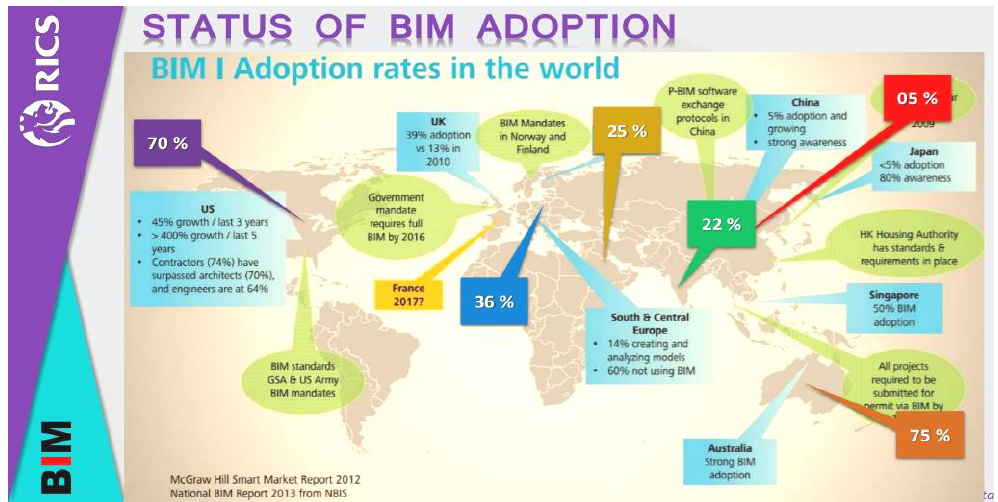
Fig. 4. Status of BIM-1 Study on BIM adoption rate in the world (Royal Institute of Chartered Surveyors (RICS), in the United Kingdom (McGraw Hill Smart Market Report, 2012, as cited in National BIM Report, 2013, p. 9). Hindrances to acceptance and use of BIM for management of public buildings are described